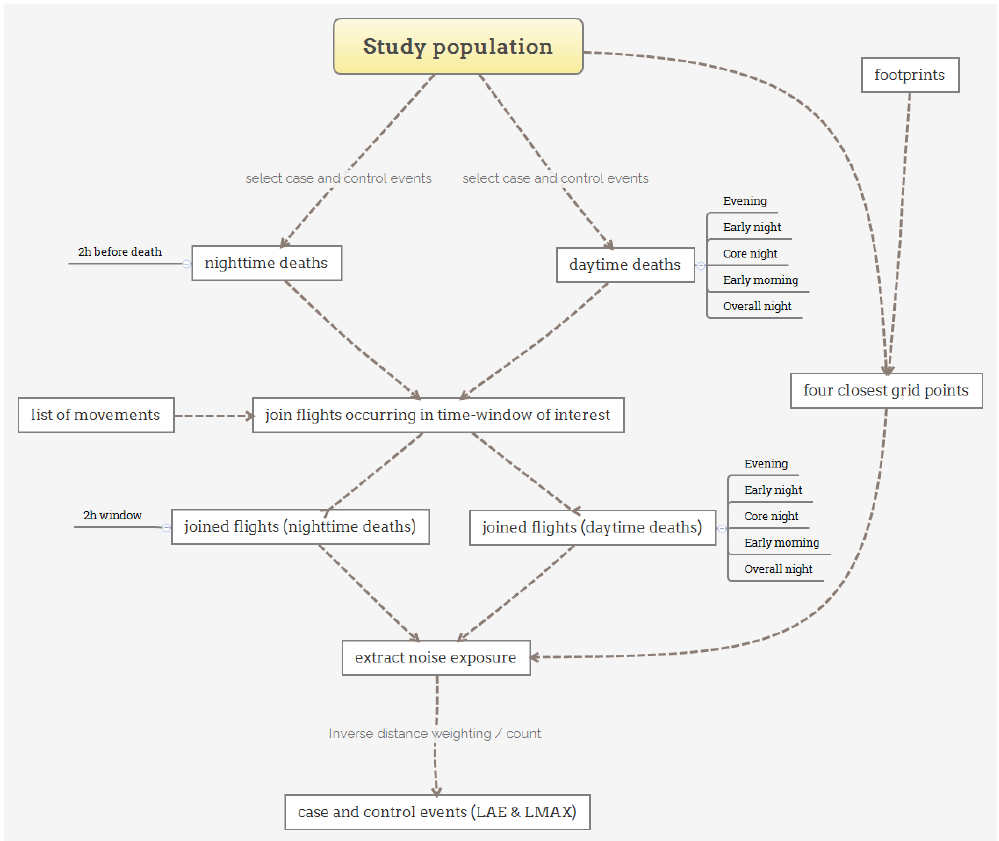
Figure 4. Graphical overview of the noise exposure assessment